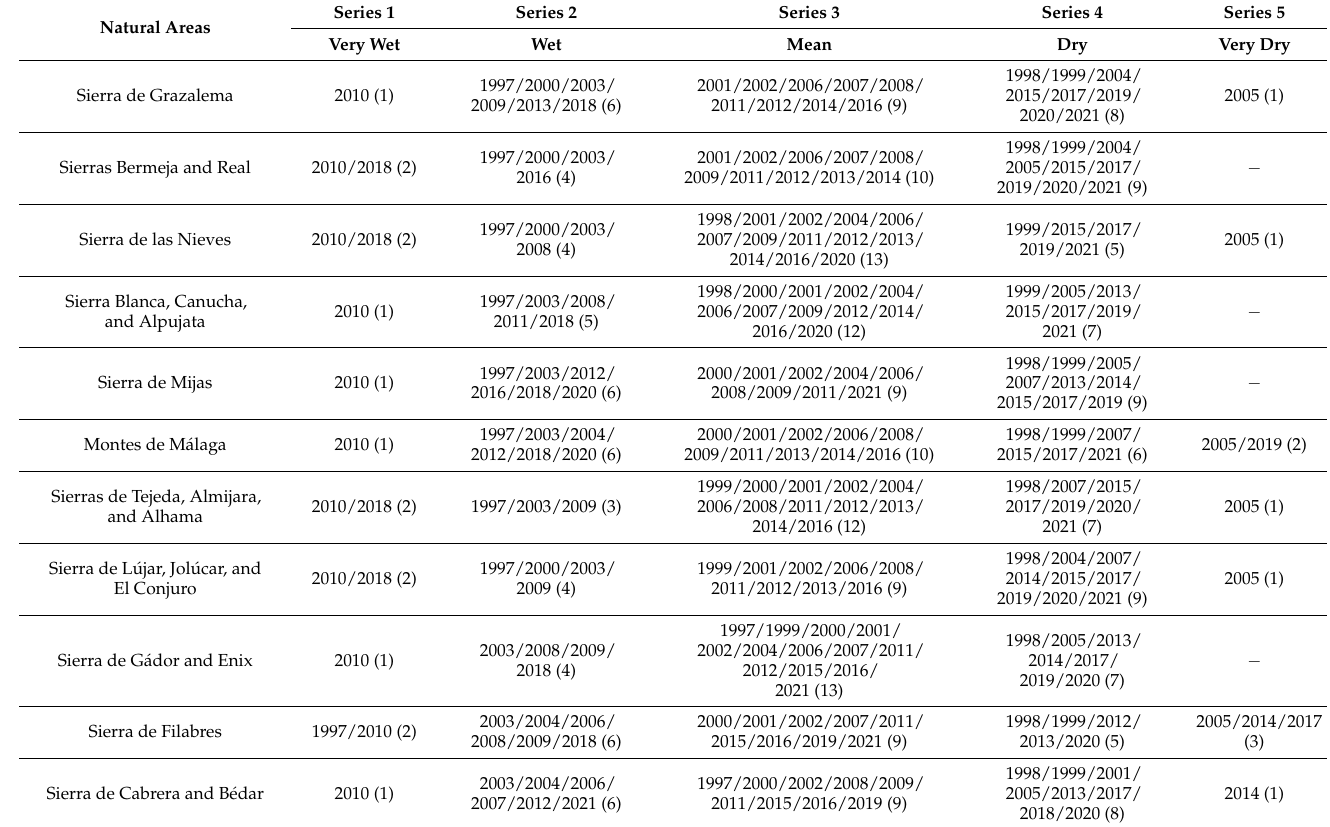
Table 5. Time series (1997–2021). Assignment of years according to their categorization by the volume of